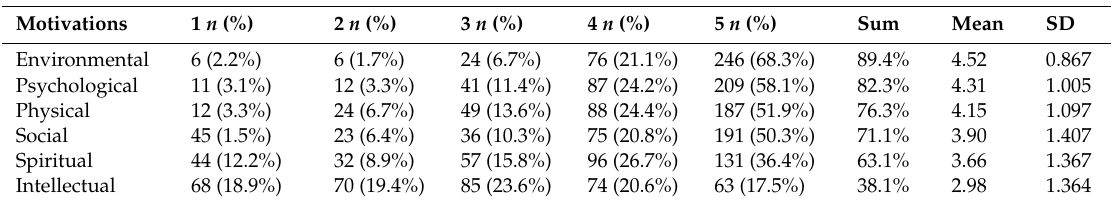
Table 3. Rating of health and well-being motivations for visiting the PNA. Descriptive statistics and tests of significance (N =